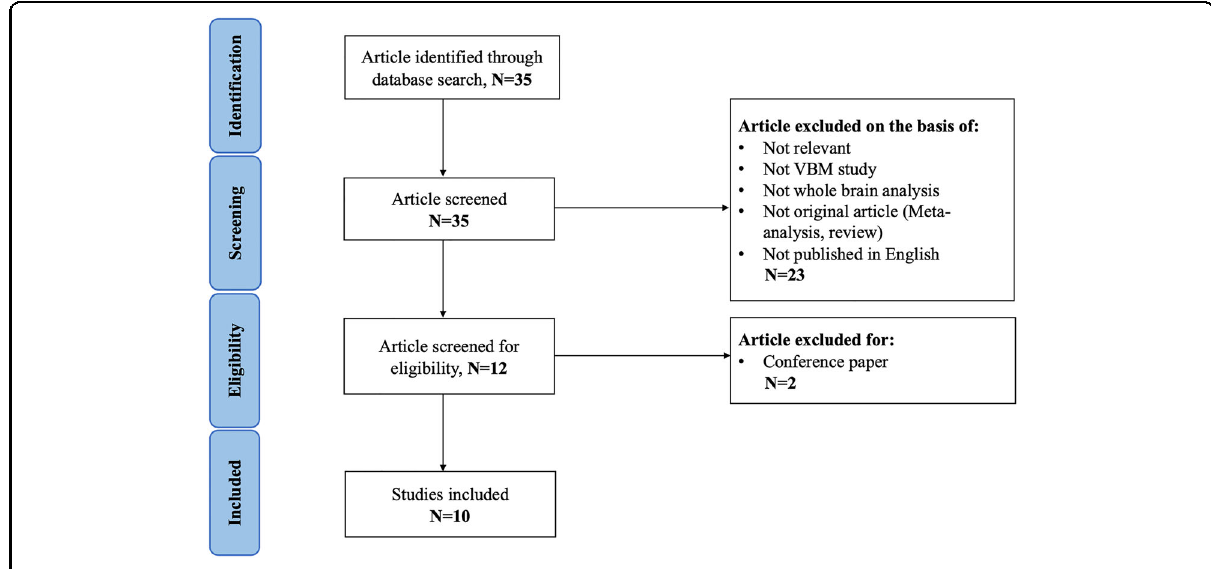
Fig. 1 Search strategy used for the inclusion of the studies considered in the current meta-analysis. Abbreviation : VBM voxel-based